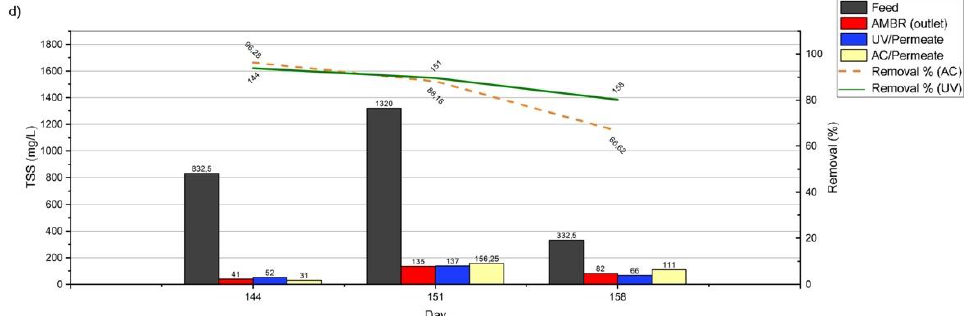
Figure 6. Removal of ( a ) COD, ( b ) TOC, and ( c ) TSS in the feed, ANX reactors, and outlet of AMBR, UV, and AC during the experiment. ( d ) Removal and average of TSS of feed, and in the outlet of AMBR, UV, and AC after day 144. Table 6. Results obtained from previous studies.